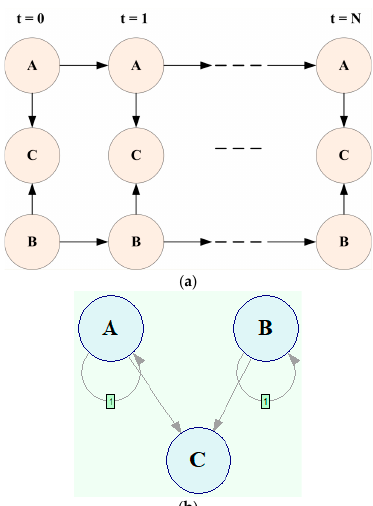
Figure 2. ( a ) A simple diagram of an unrolled three-node DBN. ( b ) DBN diagram with self-rolling nodes corresponding to Figure 2a.